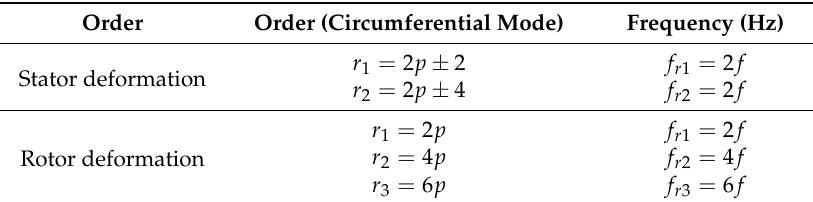
Table 3. Additional contents of radial magnetic force density in the